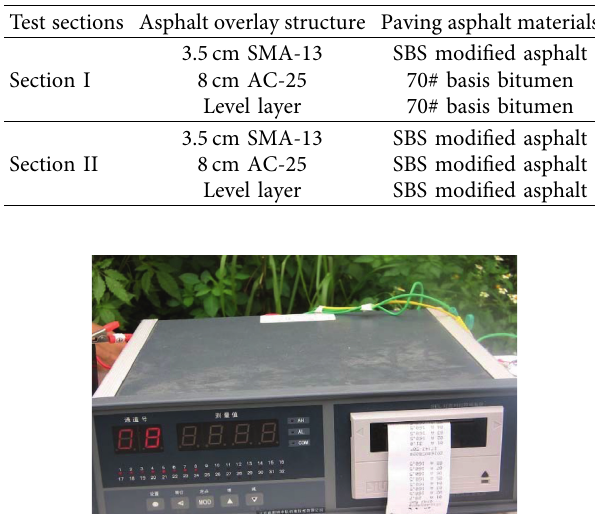
Table 2: Asphalt overlay structure and paving asphalt materials.